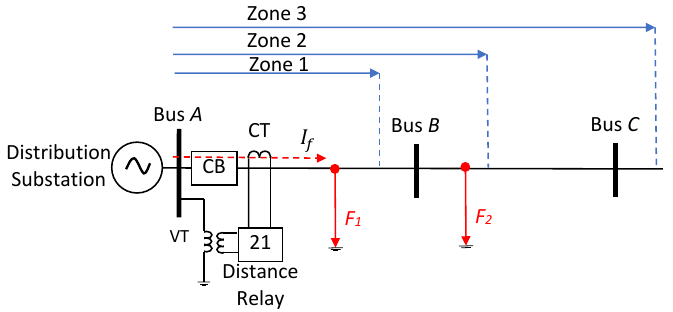
Figure 2. Distance relay protection zones for a radial